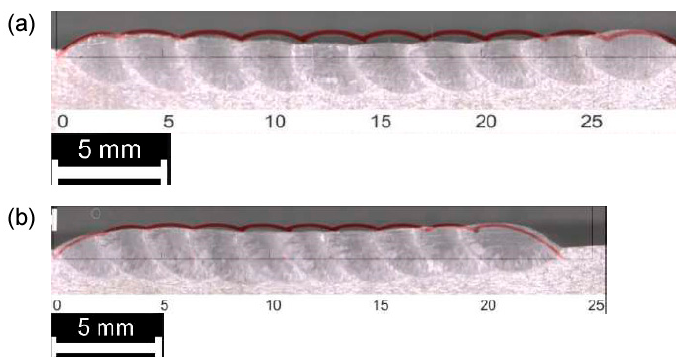
Figure 12. Comparison between theoretical (red, superimposed) and actual profile, multi-track, single-layer deposition: ( a ) 33% OR ; ( b ) 50% OR .